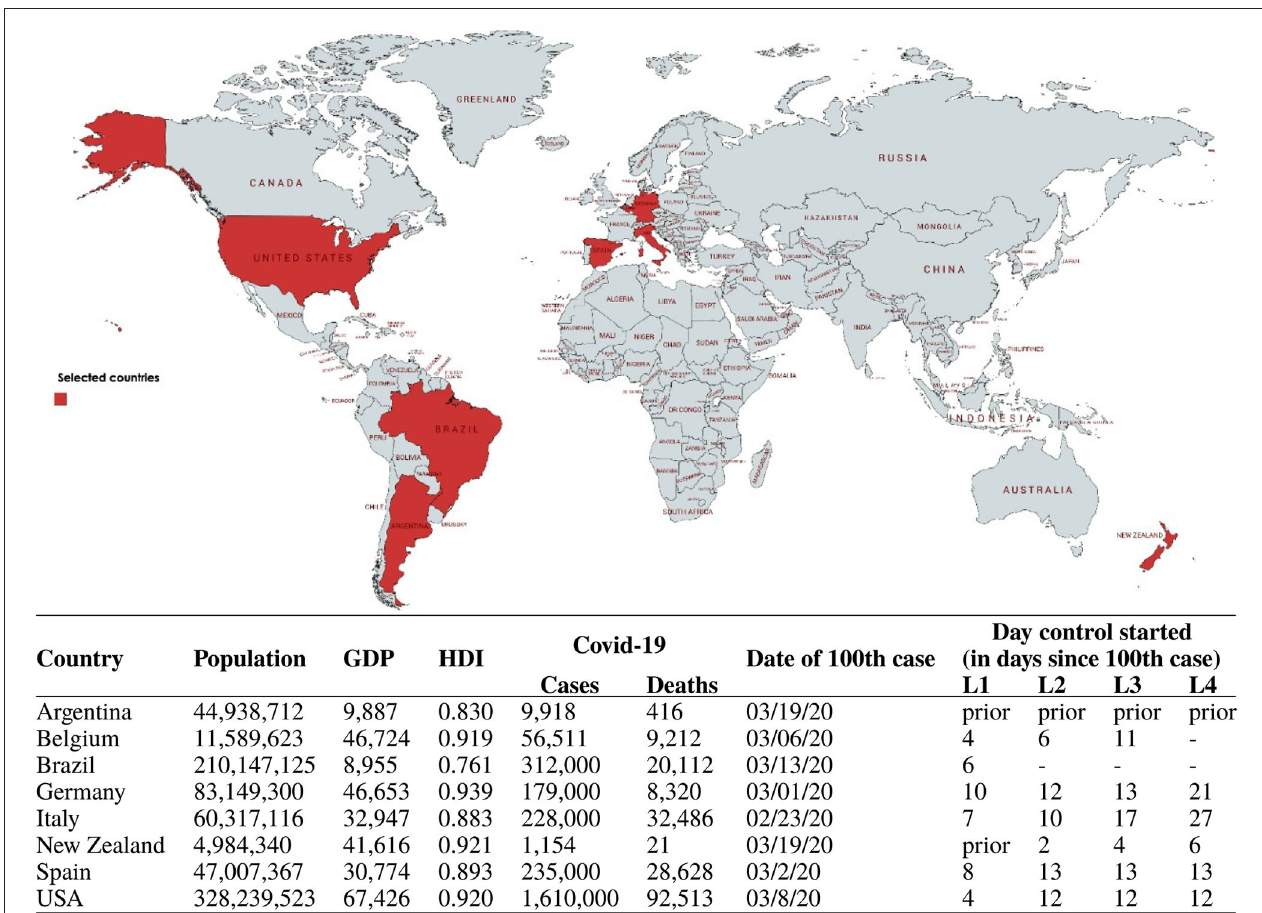
FIGURE 1 | Sociodemographic and COVID-19 data for the eight countries targeted in this study. COVID-19 data accessed on 22/05/2020 on https://coronavirus.jhu. edu/map.html. Intervention data gathered from reference [ 29]. GDP per capita in US$. Interventions are categorized into Alert Levels 1 to 4 according to the New Zealand framework (L1, Level 1, Prepare; L2, Level 2, Reduce; L3, Level 3, Restrict; L4, Level 4, Eliminate) [ 29]. Map from